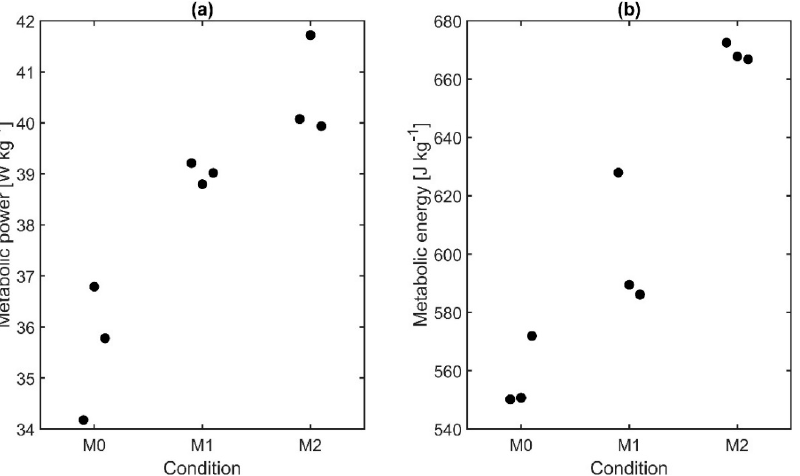
Figure 8. ( a ) Metabolic power (median values) and ( b ) metabolic energy of subject 8 for three repetitions per condition normalized to body weight.